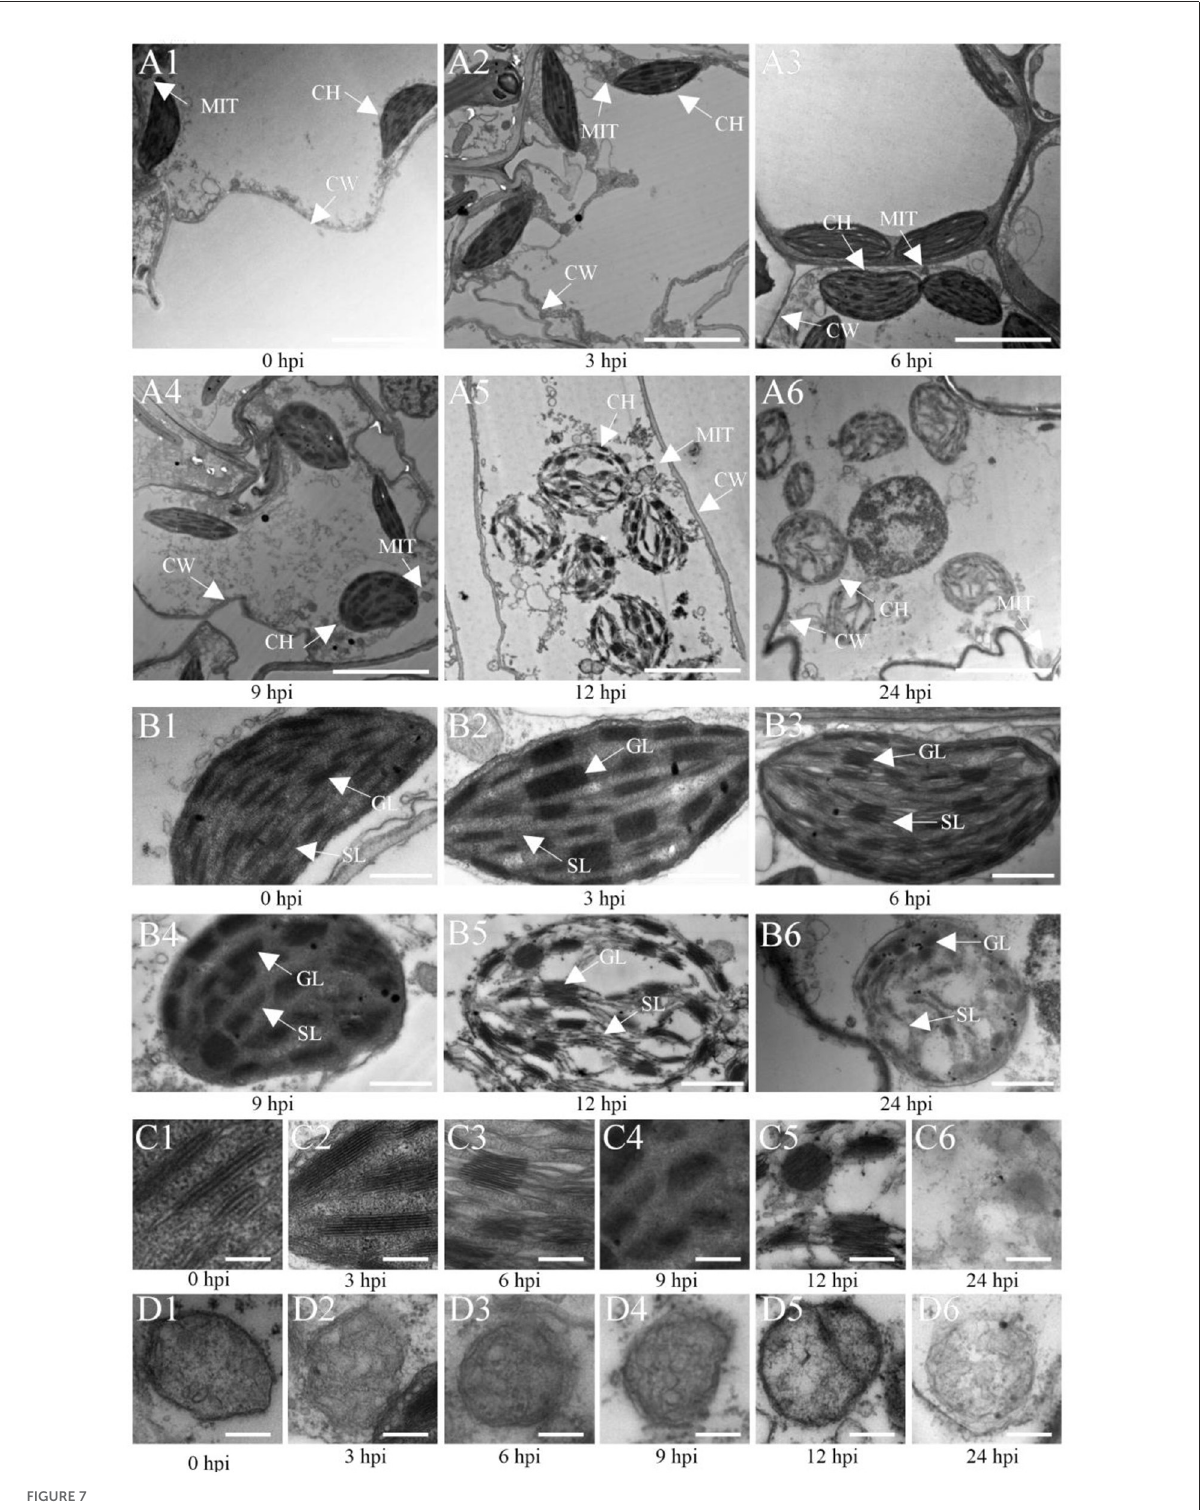
FIGURE7 Transmission electron microscopic (TEM) images of Ye478 leaves infected with Ustilago maydis . TEM images show sheath cells and mesophyll cells (A1–A6) , chloroplasts of sheath cells (B1–B6) , grana of chloroplasts (C1–C6) , and mitochondria of chloroplasts (D1–D6) at 0, 3, 6, 9, 12, and 24 hpi, respectively. CW, cell wall; CH, chloroplast; MIT, mitochondria; GL, grana lamella; SL, stroma lamella. Scale bars: (A1–A6) 5 µ m; (B1–B6) 2 µ m; (C1–C6,D1–D6) 0.5 µ